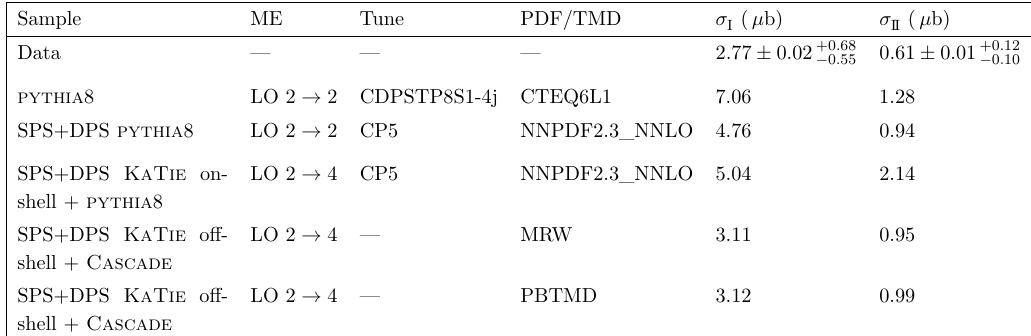
Table 5 . Cross sections obtained from data and from models with an explicit DPS contribution in Region I and Region II of the phase space, where ME stands for matrix element. that the DPS samples contribute in the low- p region, and mostly in the forward T